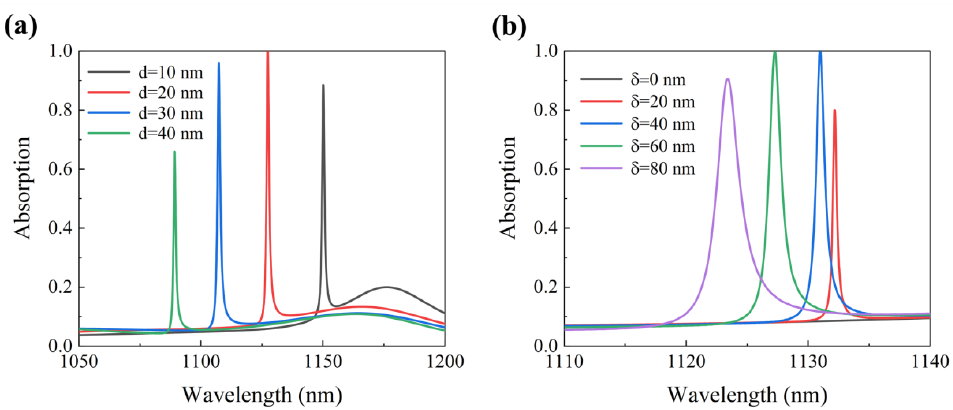
Figure 6. ( a ) Absorption spectrum for different slit widths. ( b ) Absorption spectrum for different asymmetry parameters.